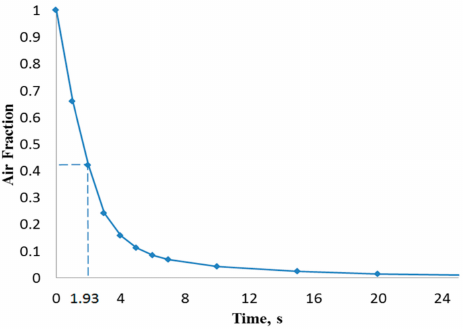
Figure 6. Overall air volume fraction in the chamber vs. filling time at a liquid flow rate of 100 µ L/min.